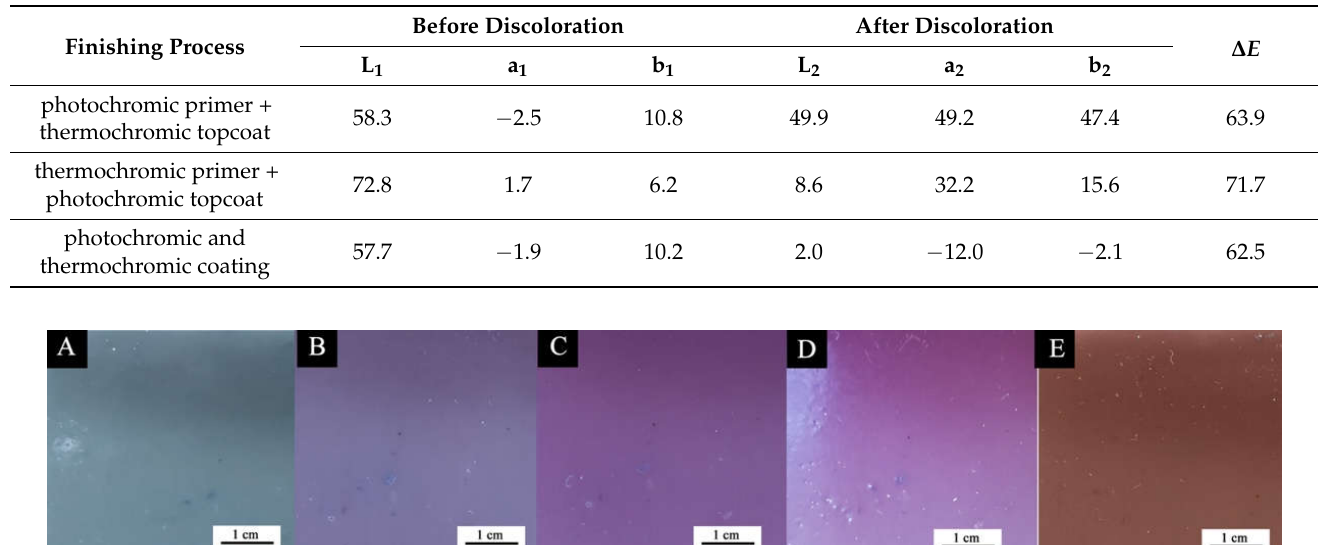
Table 3. Photochromic chromaticity value of the film under different finishing sequences.